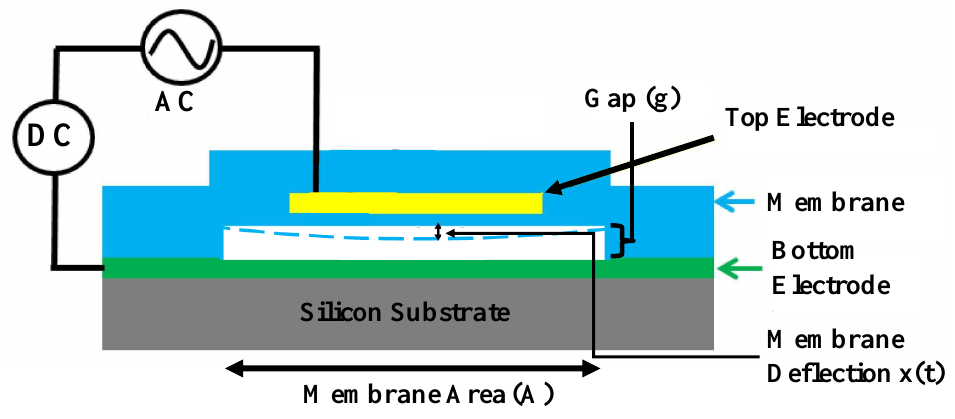
Figure 1. Basic CMUT